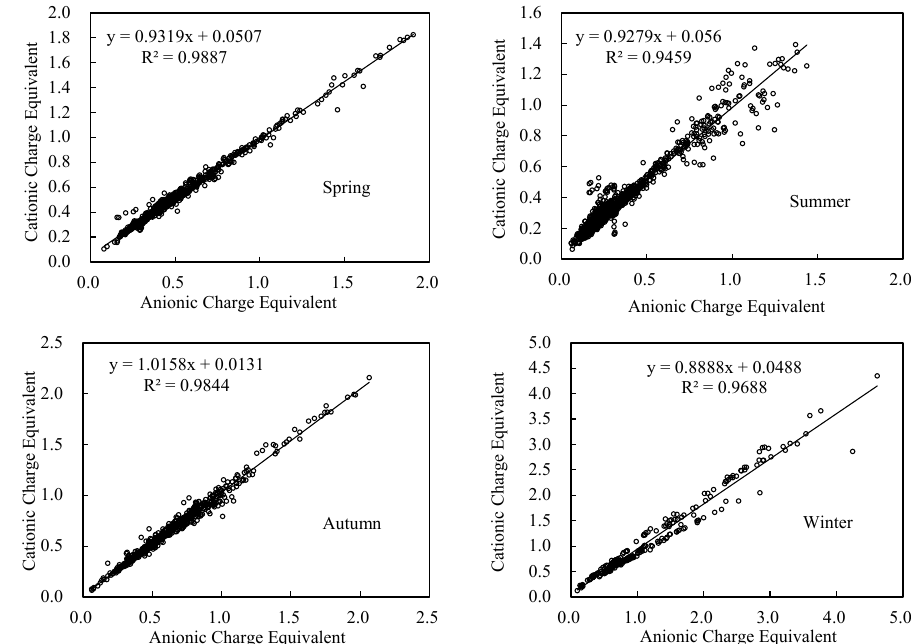
Figure 5. The charge balance of anion and cation water-soluble ions in Wuhan in four seasons. The slope value of the linear fitting lines reached 0.9319 (R 2 = 0.9887), 0.9279 (R 2 = 0.9459) and 1.0158 (R 2 = 0.9844) in spring, summer and autumn, respectively. All values were nearly 1, while the slope value in winter only reached 0.8888 (R 2 = 0.9688), and had a relatively large gap with 1.